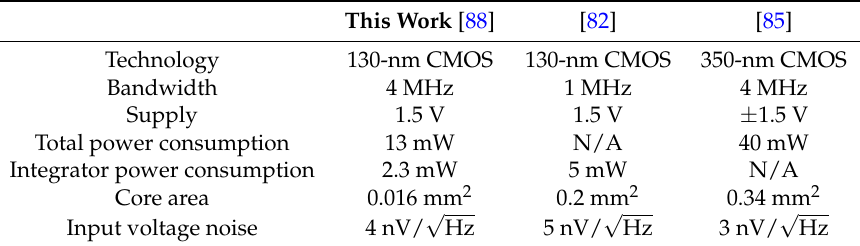
Figure 25. The layout of the integrator-differentiator transimpedance amplifier (TIA) in 130-nm CMOS. Table 1. Low-current CMOS amplifier